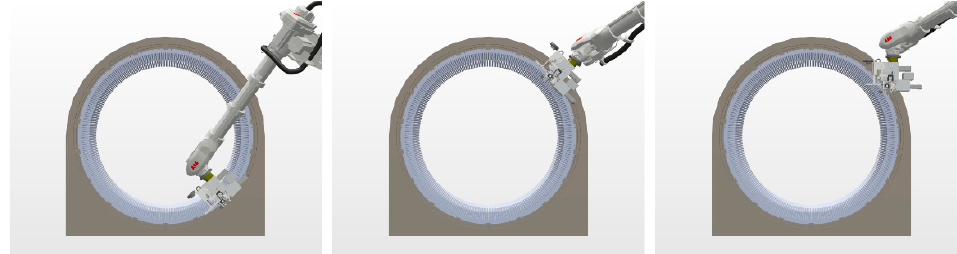
Figure 7. Robot tool positioning during winding, with the cable feeder directed radially from the inside of the stator at lower slots ( left ), radially from the outside of the stator at higher slots ( middle ) and vertical for cable dropping ( right ).